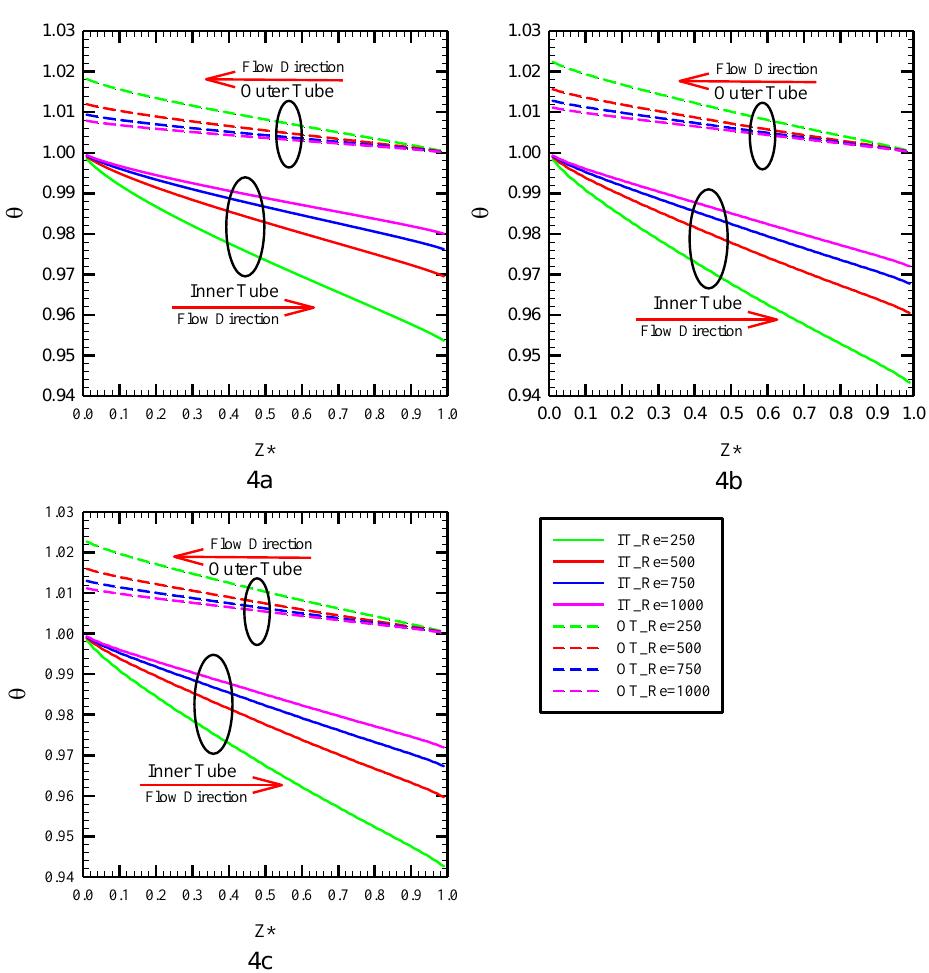
Figure 4. Local bulk temperature distribution along the length of the tube at Reynolds number of 250 for: ( a ) PHE; ( b ) Co-STT; and ( c ) Counter-STT. Nanomaterials 2020 , 10 , x FOR PEER REVIEW